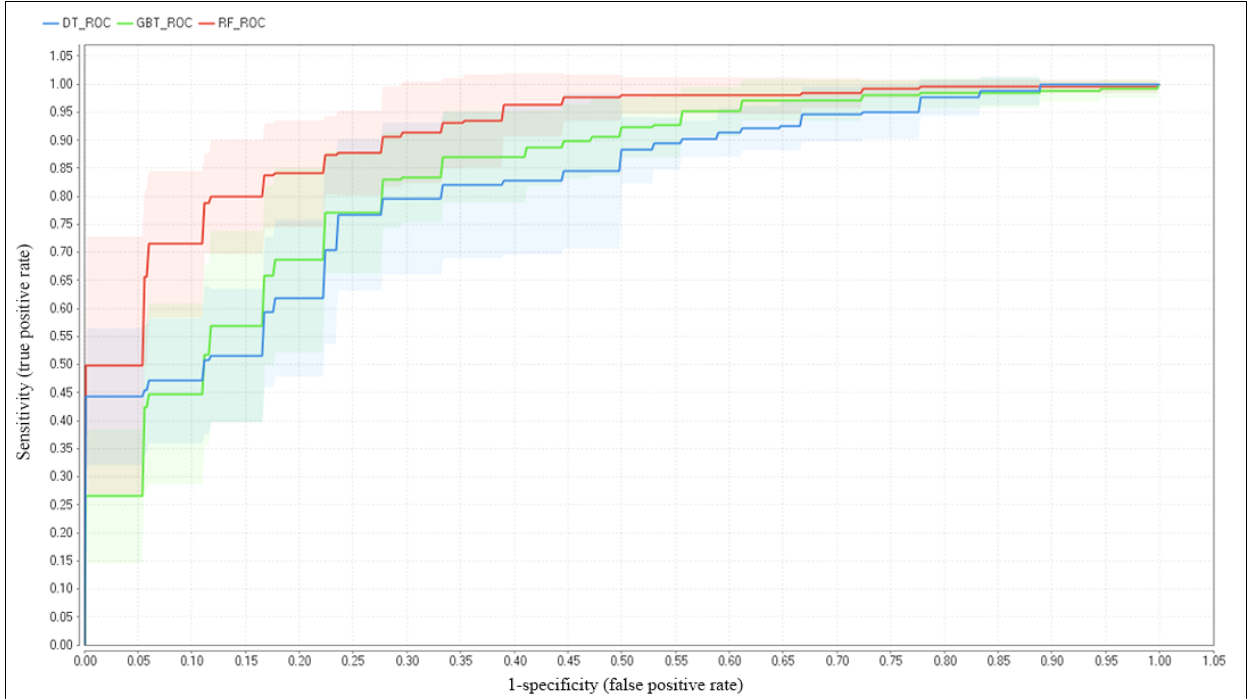
Figure 2. Depression ROCs curves of decision tree (blue line), gradient boosting trees (green line), and random forest (red line) using all trauma